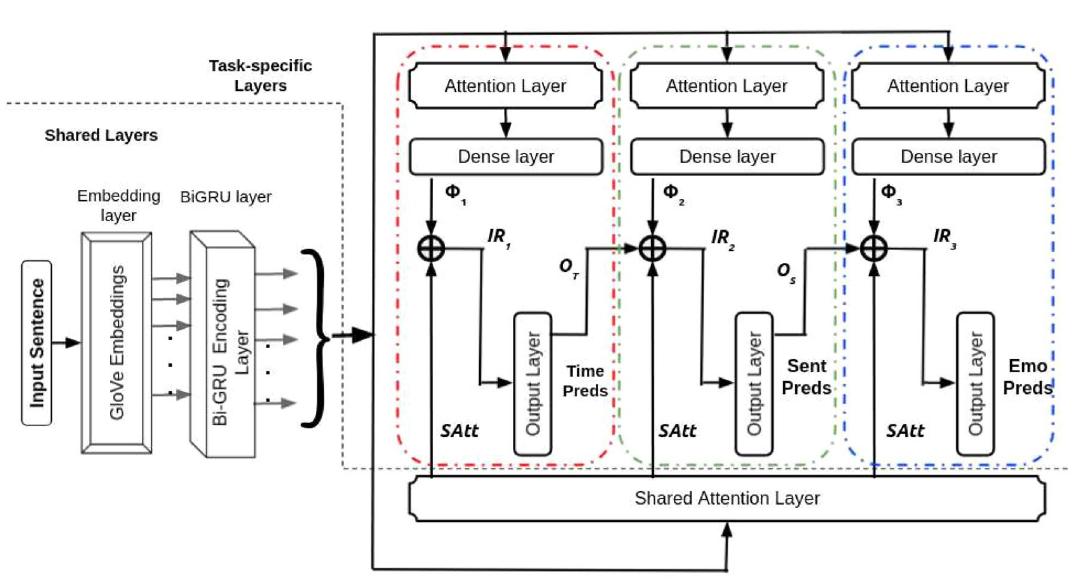
Figure 3. Architecture of shared-private attentive network with multi-layer cascades. Colour coded red, green and blue dotted lines depicts the three sub-networks participating in the layer